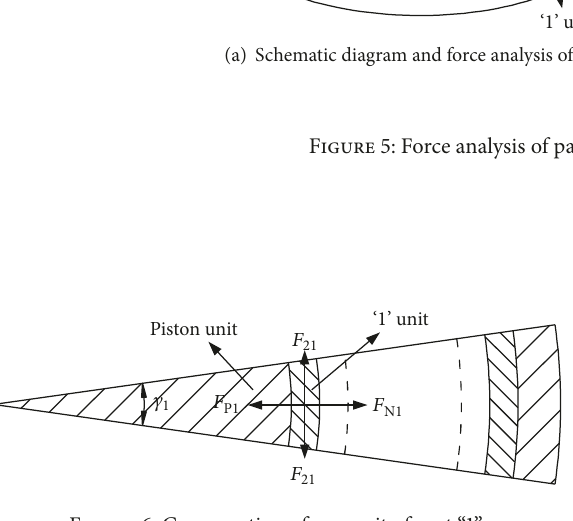
Figure 6: Cross-section of one unit of part